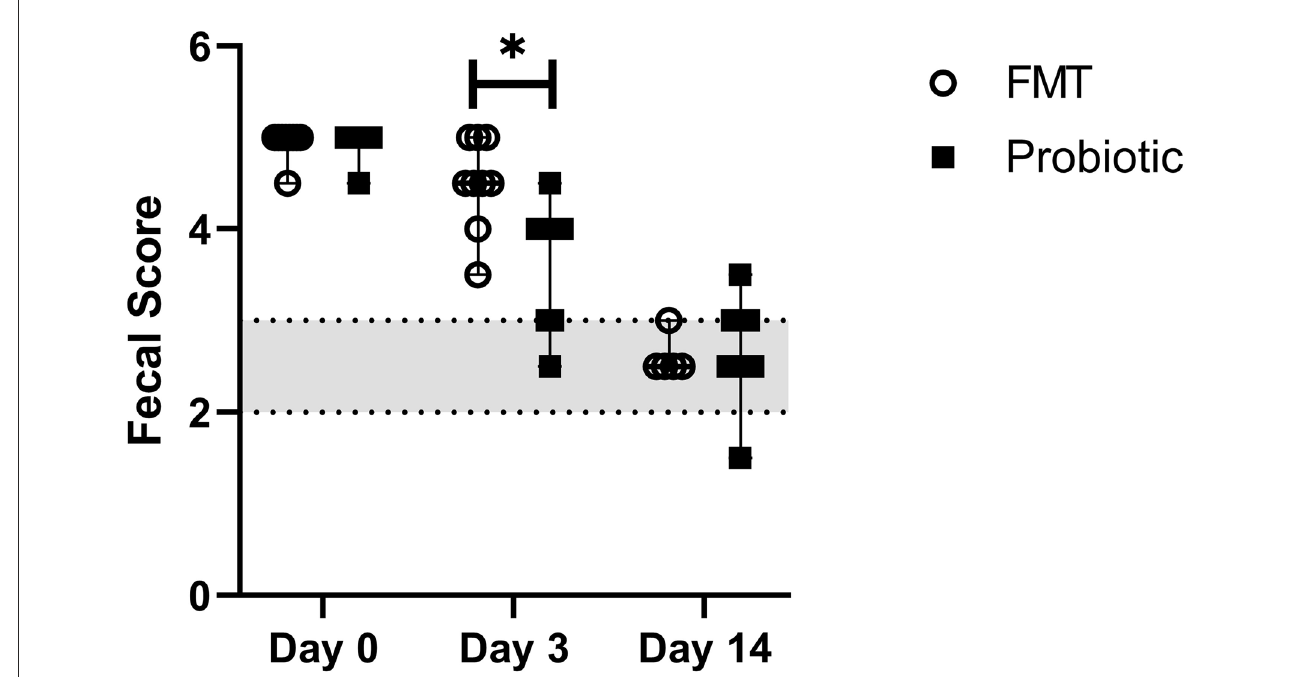
FIGURE3 Line plot of serial fecal scores in 18 dogs with acute hemorrhagic diarrhea syndrome receiving either fecal microbiota transplant (FMT) or probiotic. Data are expressed as median (range); data points represent individual dog values. Asterisk (*) indicates a significant difference ( p < 0.05) when comparing treatment groups on day 3. The shaded region denotes a normal fecal score, where a score ≥ 3.5 is considered